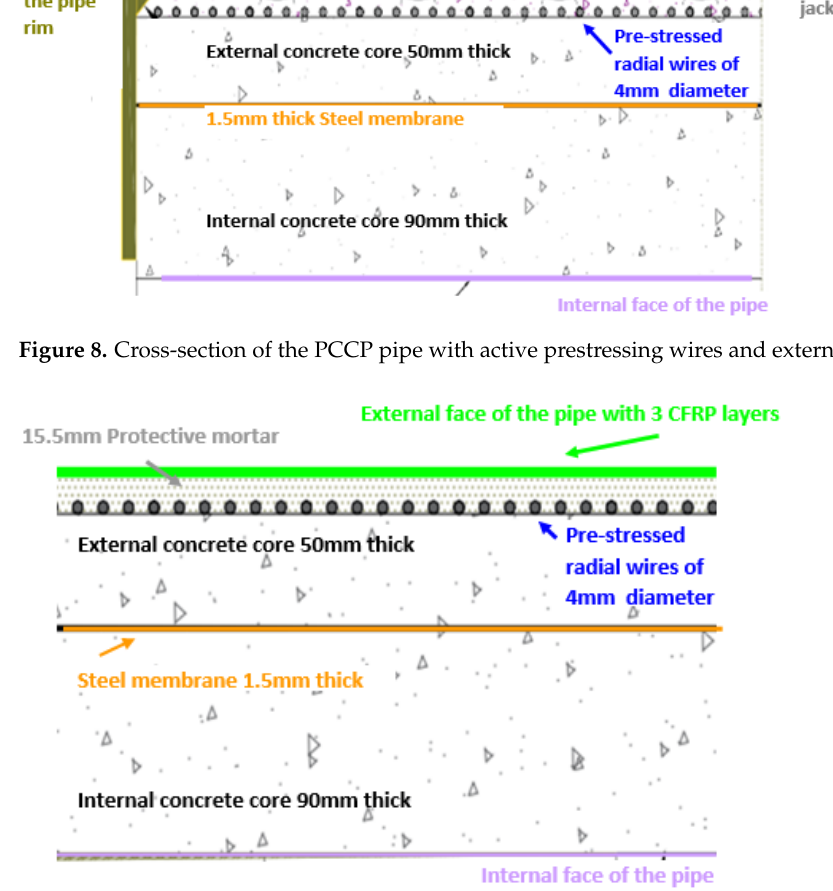
Figure 9. Cross ‐ section of the PCCP pipe with active prestressing wires and external CFRP layers.